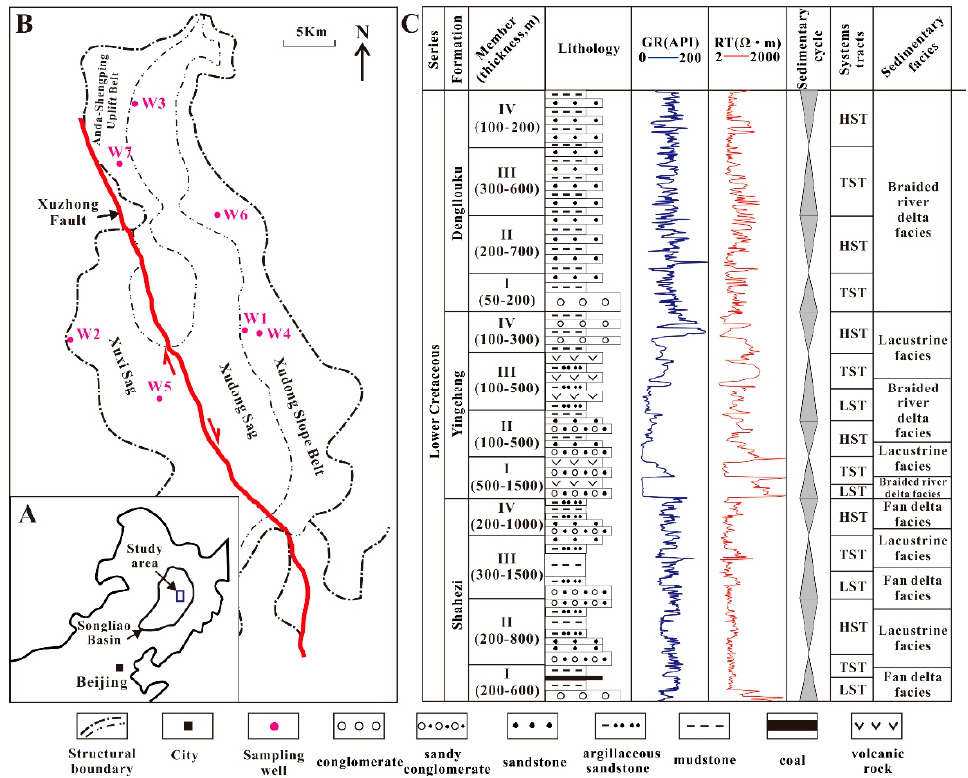
Figure 1. Diagrams showing ( A ) locations of the Songliao Basin and the study area, ( B ) main tectonic units of the Xujiawei Rift and locations of sampling wells, and ( C ) stratigraphic sequence of the Lower Cretaceous Shahezi, Yingcheng, and Denglouku Formations in Xujiaweizi